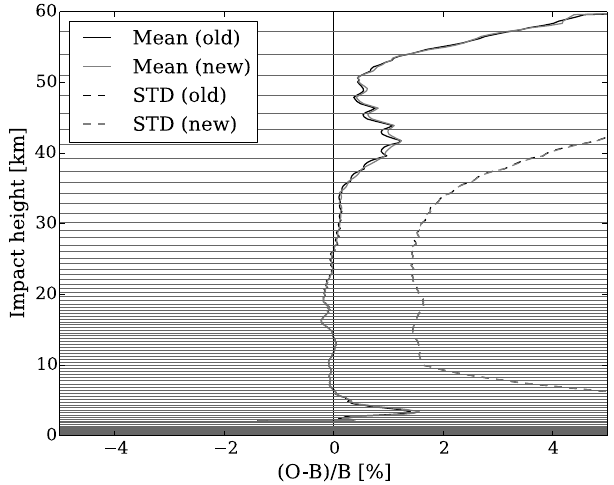
Figure 10. Bending angle innovation statistics from the 91-level ECMWF model, using observations from all RO instruments over a 30-day period (April 2013). Typical model level heights are over- laid. The statistics generated using the original “ROPP” operator are plotted in black, and the ECMWF implementation of the improved operator is plotted in grey (see Appendix A3 for full